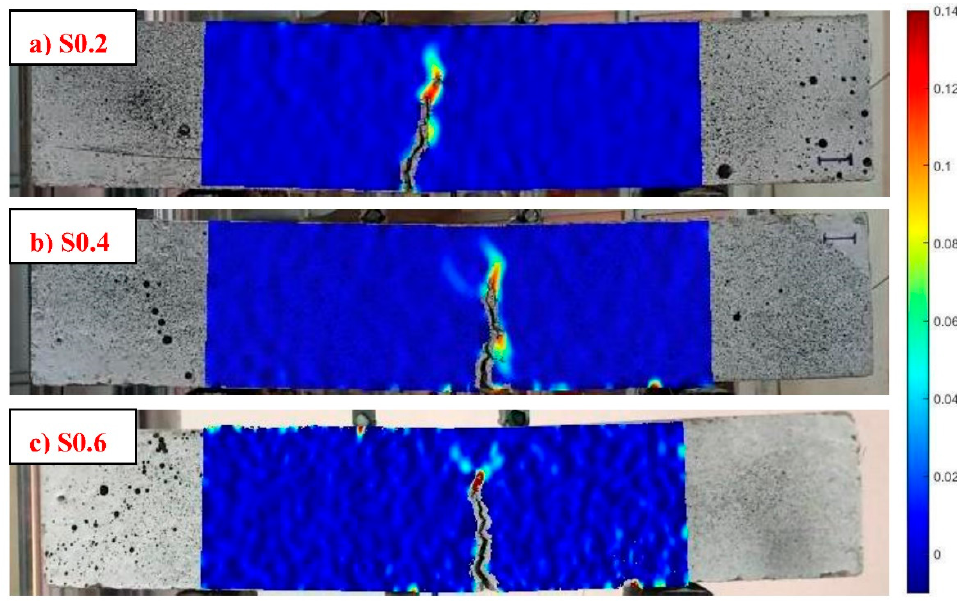
Figure 13. DIC images corresponding to the L/100 (3 mm) deflection level.